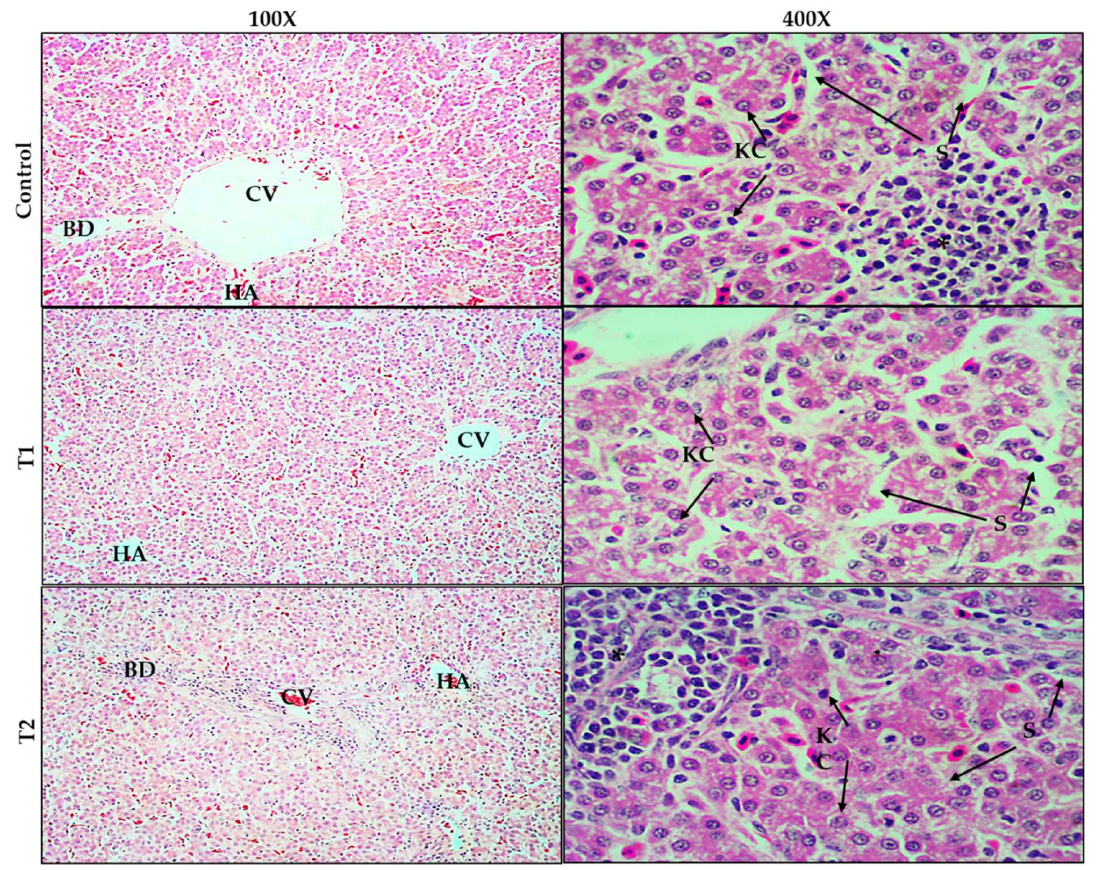
Figure 1. Histological changes in the liver of broiler chickens stained with (H&E) 100 × to 400 × . Control, birds fed basal diet; T1, basal diet containing 0.75 g Tribulus Terrestris /kg feed; T2, basal diet containing 1.5 g Tribulus Terrestris /kg feed. CV = central vein; S = sinusoids; KC = Kupffer cells; HA = hepatic artery; BD = bile duct. Chicken liver (control): shows normal morphology of hepatocytes with focal inflammatory infiltration by leukocytes (lymphocytes) (star) and dilatation of the CV. Chicken liver (T1): hepatocytes are more normal but sinusoidal spaces are dilated (S) and CV is narrower than control group. The chicken liver (T2): hepatocytes normal, but swollen hepatocytes in some areas with lymphocyte infiltration around the central vein (star) and loss of lining endothelial cells.